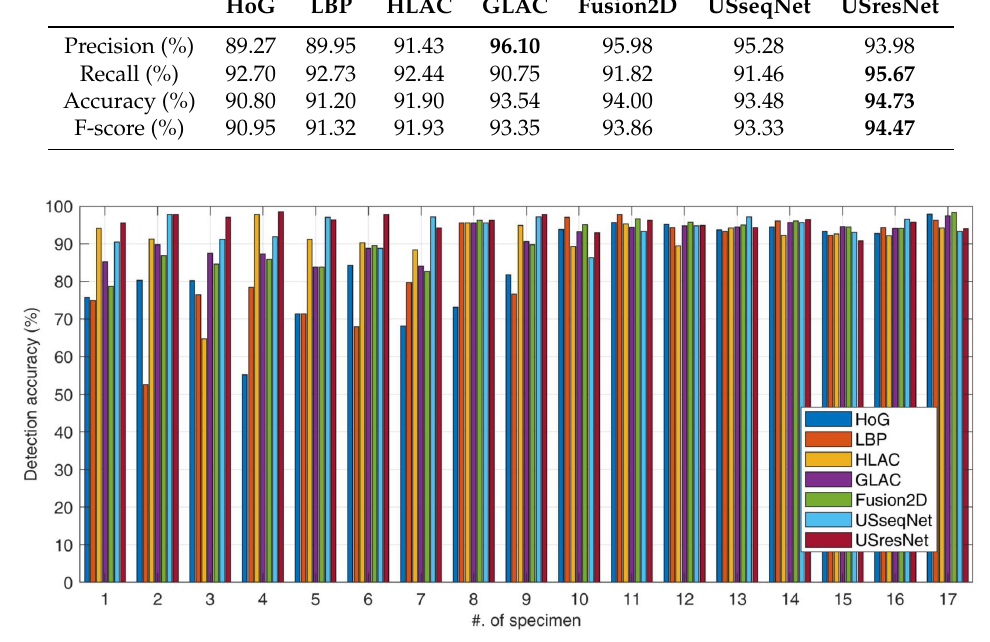
Figure 9. Specimen-wise classification accuracy